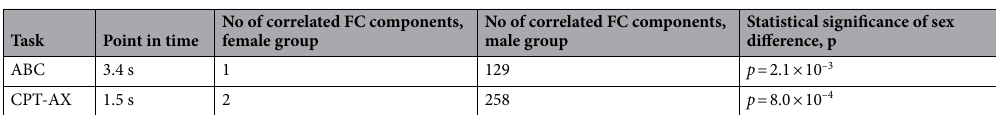
Table 2. Number of FC components correlated with Or in female and male groups at specified points in time for ABC task and CPT-AX task. Column 2 indicates the point in time for the female-male comparison of the number of FC components correlated with Or during the ABC and CPT-AX tasks. The number of correlated FC components is listed for both females and males and the statistical significance of the sex difference in the number of correlated FC components is listed in the subsequent 3 columns. The statistical significance of the sex difference in the number of correlated FC components was determined using the described permutation